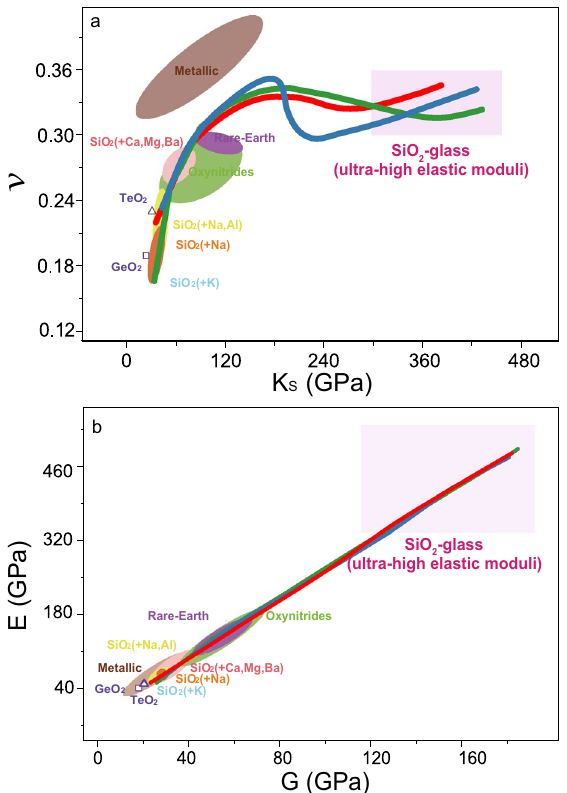
Figure 5. Comparison of Poisson’s ratio and elastic moduli of oxide and metallic glasses. ( a ) Poisson’s ratio ( ν ) versus bulk modulus ( K S ). ( b ) Young’s modulus ( E ) as a function of shear modulus ( G ). Green, blue, and red lines represent our results at 300 K, 750 K and 1000 K by compression, respectively. Triangle: TeO 2 glass 12 ; square: GeO 2 glass 12 ; light blue: SiO 2 glass with K 16 ; orange: SiO 2 glass with Na 10 ; SiO 2 glass with Na and Al 15 ; pink: SiO 2 glass with Ca, Mg and Ba 14,17 ; light green: oxynitride glasses 53 ; purple: rare-Earth glasses 18,54 ; brown: metallic glasses 19,55